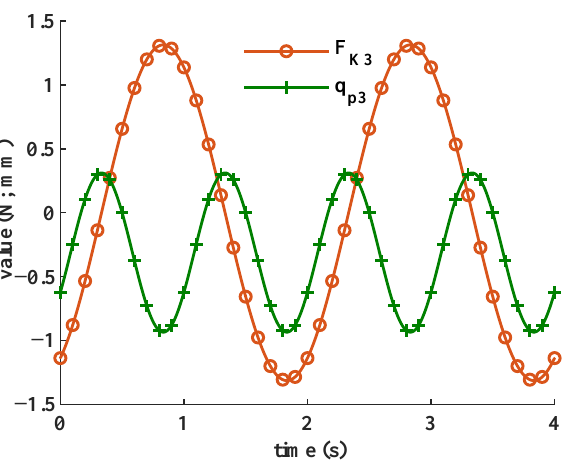
Figure 14. Stiffness-related component, F K 3 , of the required active force, and the corresponding flexure-based passive prismatic joint displacement q p 3